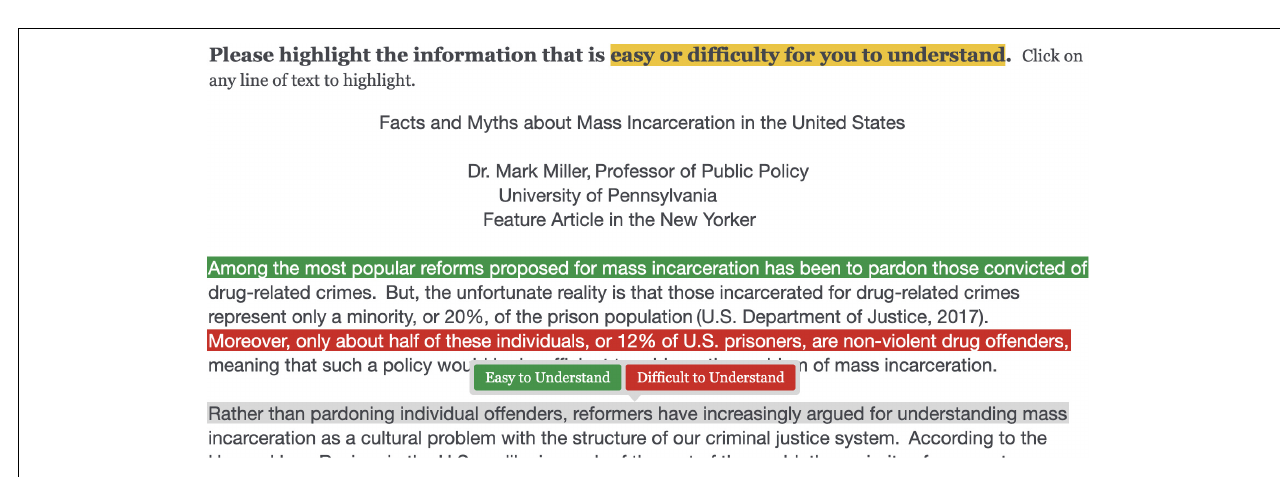
FIGURE 2 | Screenshot of highlighter tool for the intertextual strategy condition.